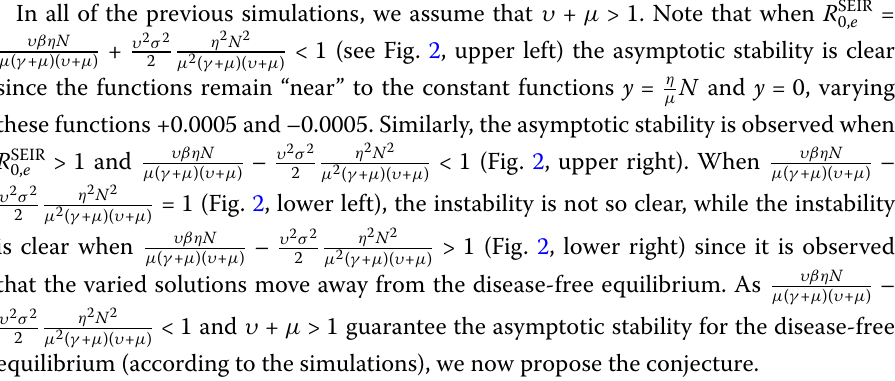
Figure 2 Stability modeled using the parameters N = 1, β = 0.8, σ = 0.3, μ = 0.4, η = 0.9, and (a) γ = 0.85 and υ = 0.7 (upper right), (b) γ = 0.75 and υ = 0.7 (upper left), (c) γ = βυ N η μ υ = 0.85 (lower left) and ( d ) γ = 0.55 and υ = 0.85 (lower right). The initial condition is ( N ,0,0,0) = (1,0,0,0) for all of